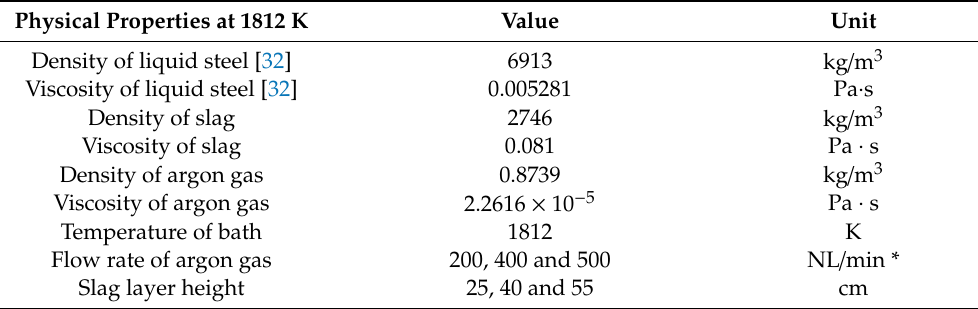
Table 1. Thermo-physical properties and operating conditions employed. Physical Properties at 1812 K Value Unit Density of liquid steel [32] 6913 kg / m 3 Viscosity of liquid steel [32]